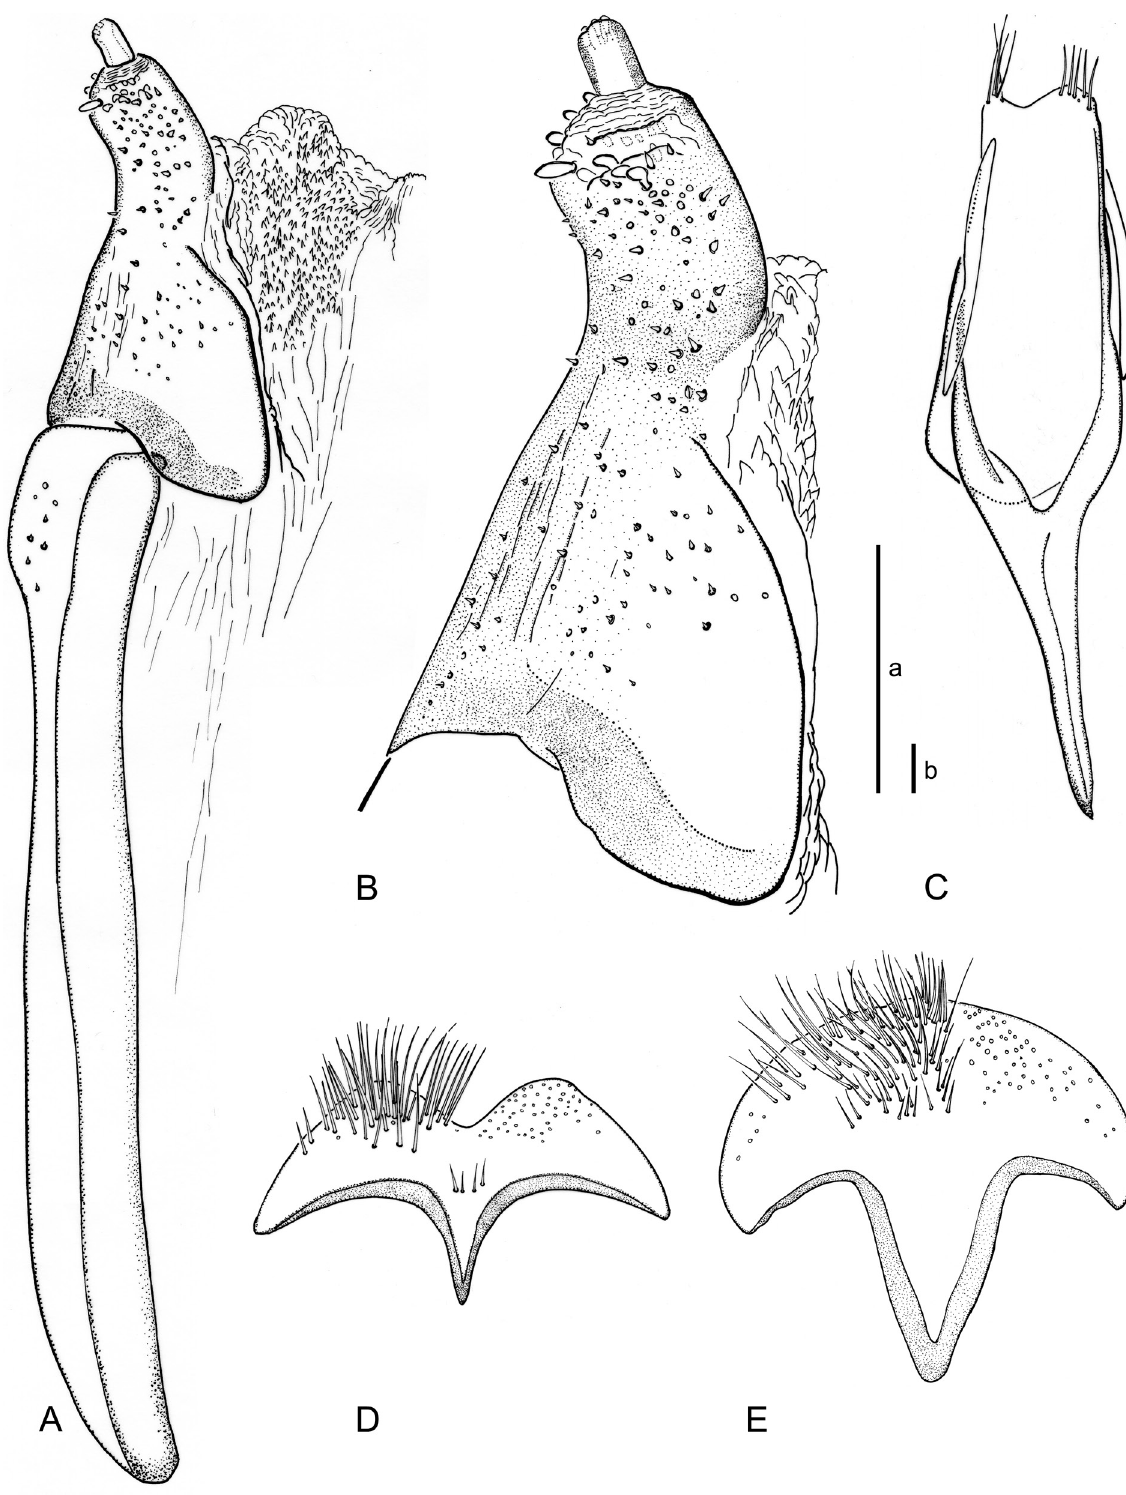
Fig. 4. Potamophilus kelabitensis sp. nov. A . Ovipositor, ventral aspect. B . Distal portion of ovipositor, ventral aspect. C . Male segment IX with the spiculum gastrale, ventral aspect. D . Male sternite VIII, ventral aspect. E . Female sternite VIII, ventral aspect. Scale bars = 0.1 mm; A = a; B–E = b. Specimens: A–B, E = female paratype (CKB); C–D = male holotype